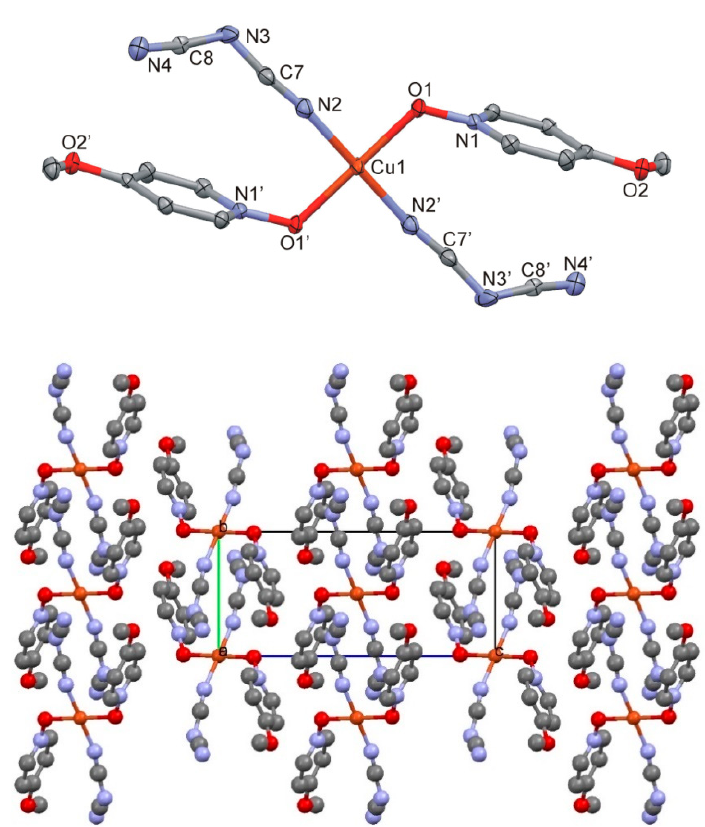
Figure 4. ( top ) Molecular plot of 4 . Symmetry operations: (’) 1-x,1-y,1-z; ( bottom ) packing plot of 4 .